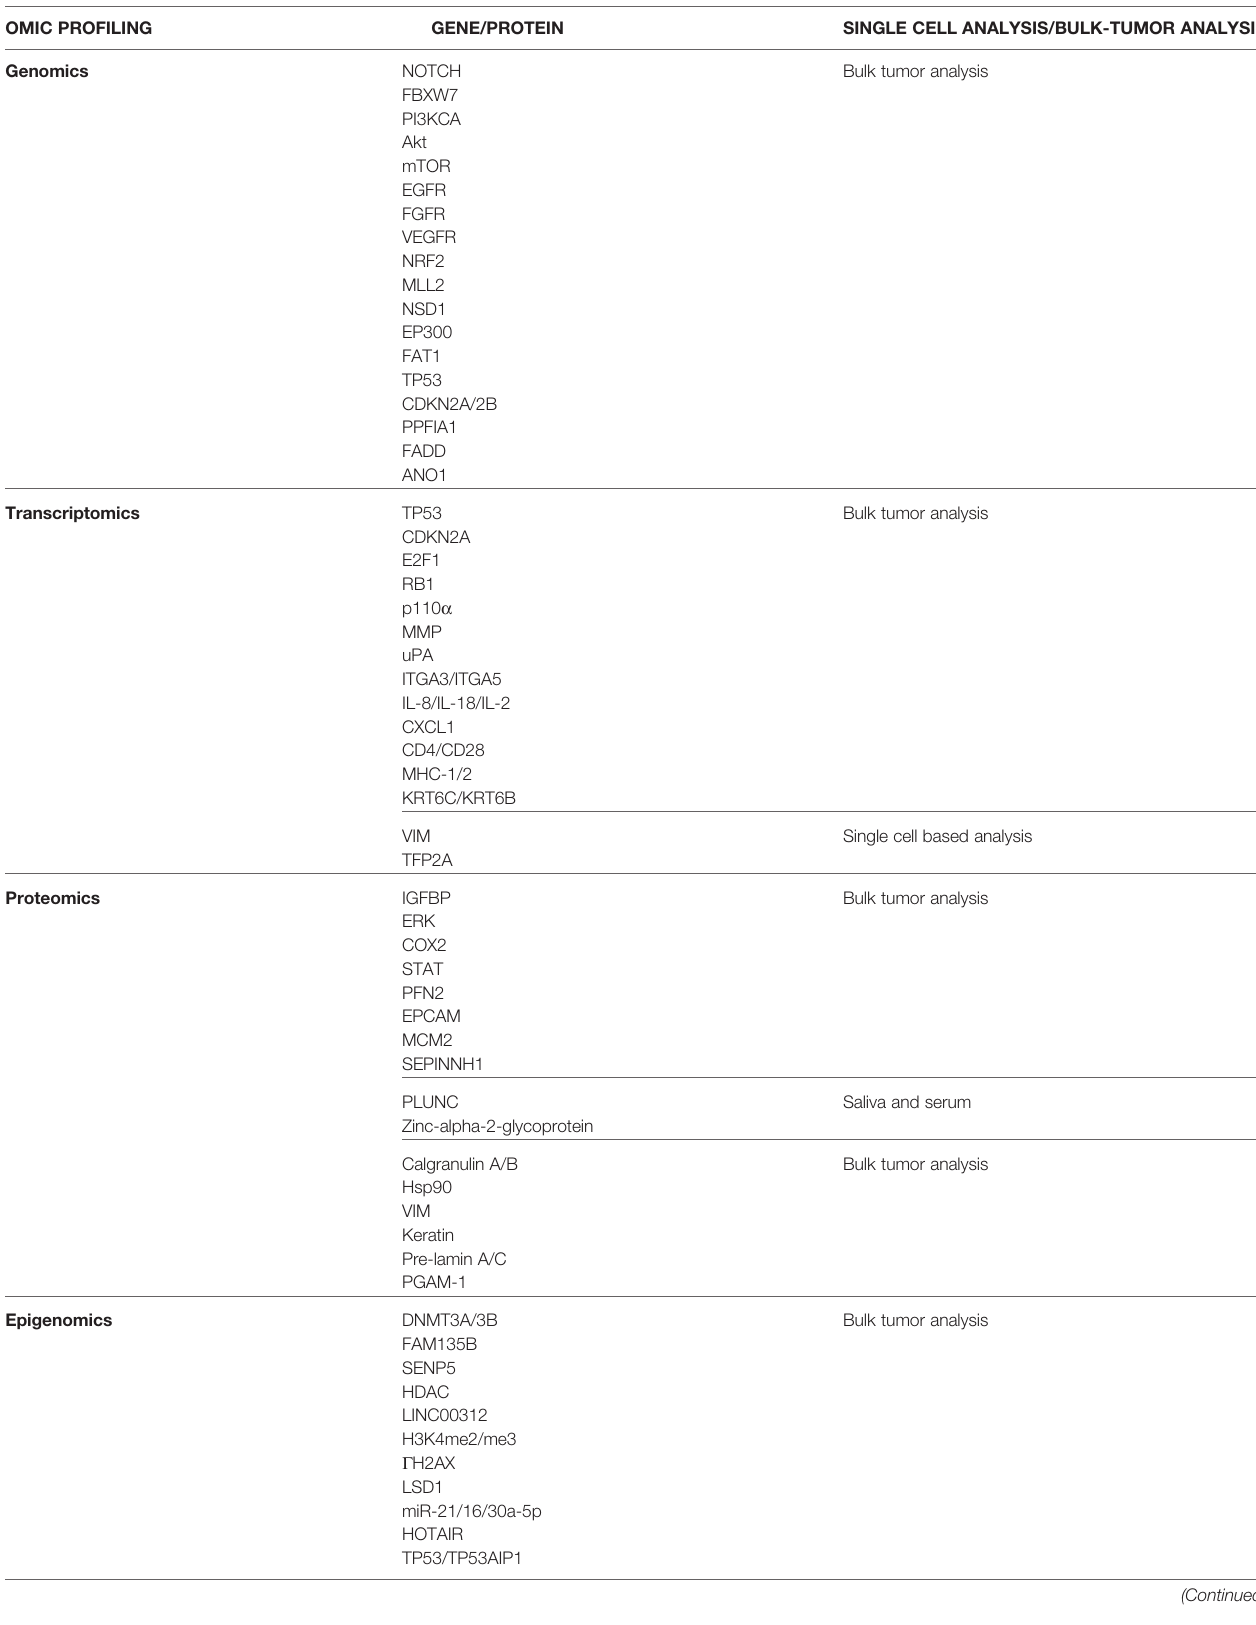
TABLE 4 | Major biomarkers identi fi ed using different forms of omics pro fi ling in head and neck cancer at single-cell level and bulk tumor